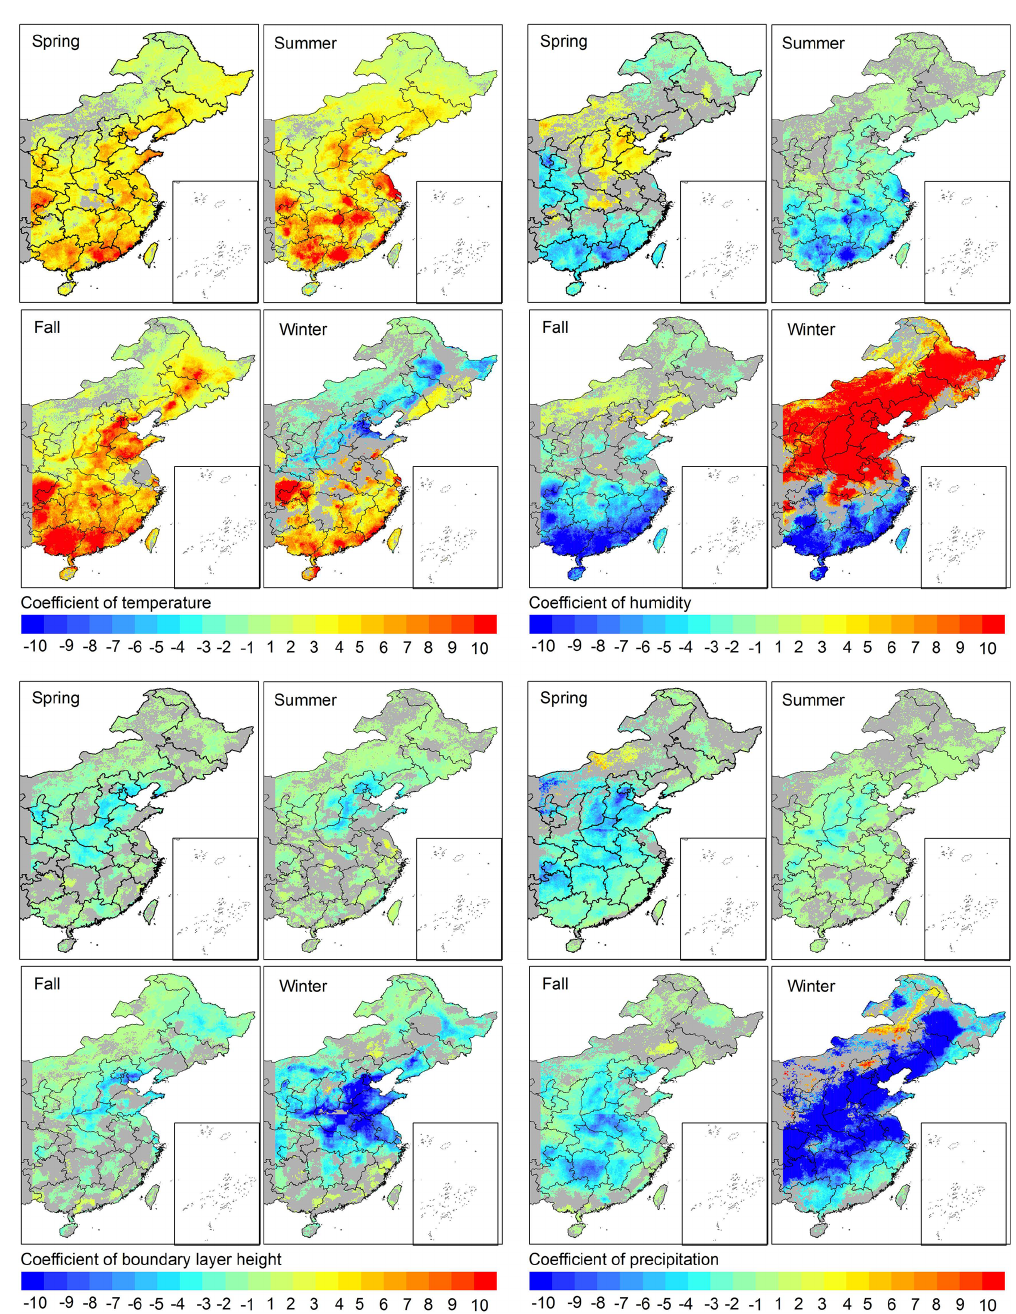
Figure A4. Distribution of the estimated seasonal coefficients of the normalized meteorological